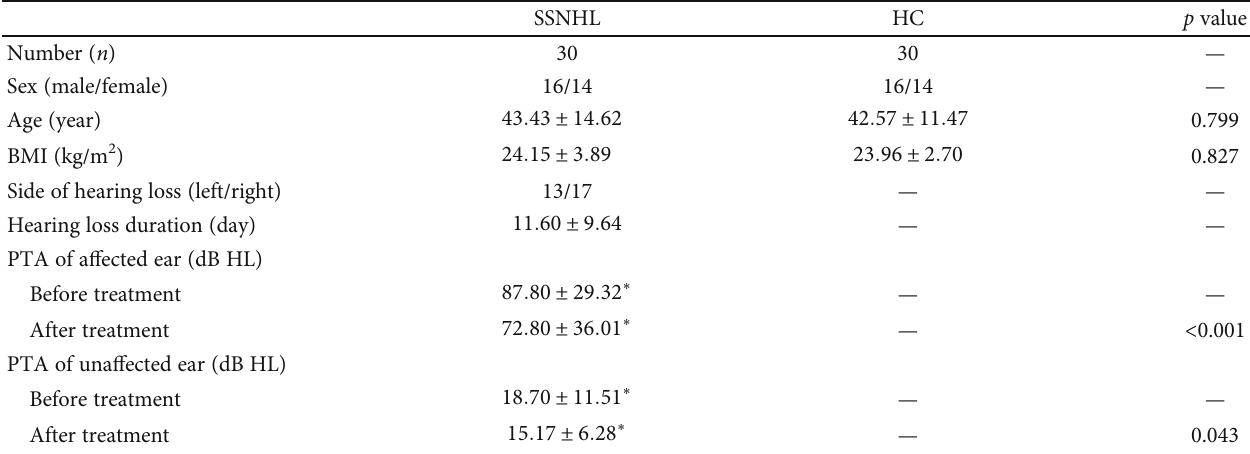
Table 1: Demographic and clinical information of the SSNHL patients and HC